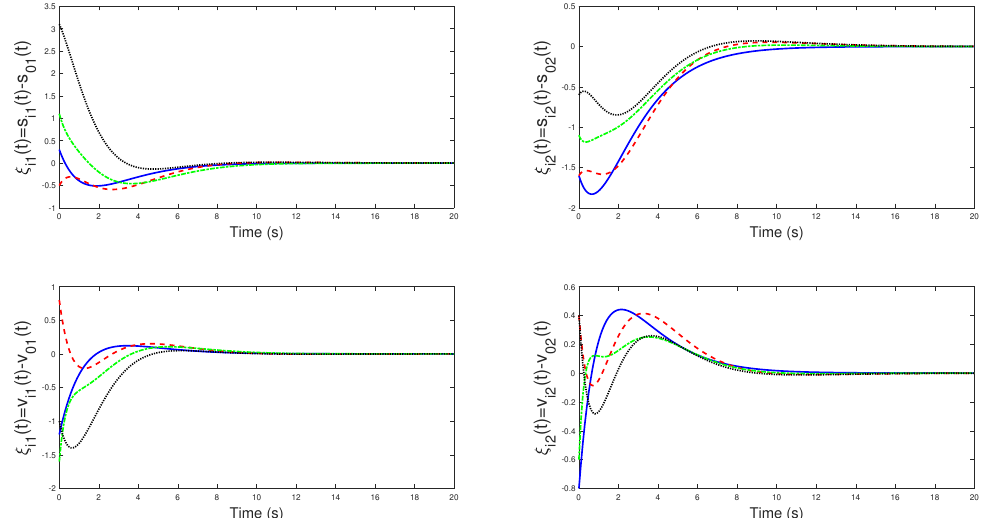
Figure 2. The tracking error responses of the displacement and velocity for all UAVs under the proposed